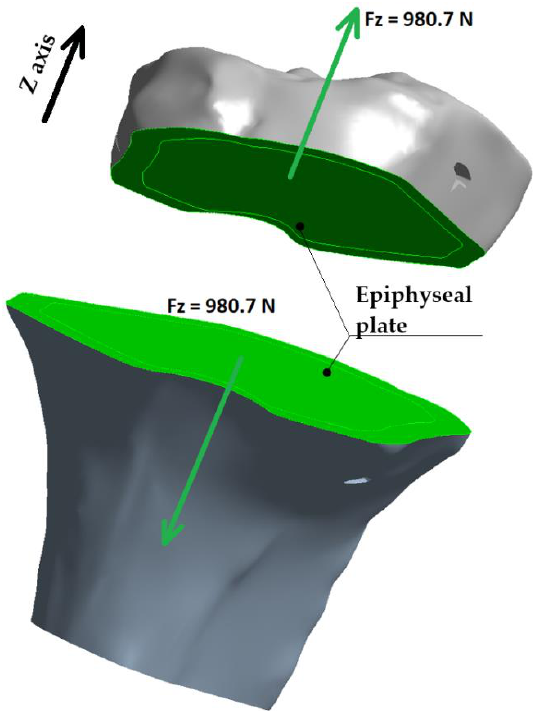
Figure 10. Force boundary condition—forces Fz (equivalent to 100 kg) acting on the epiphyseal plate.